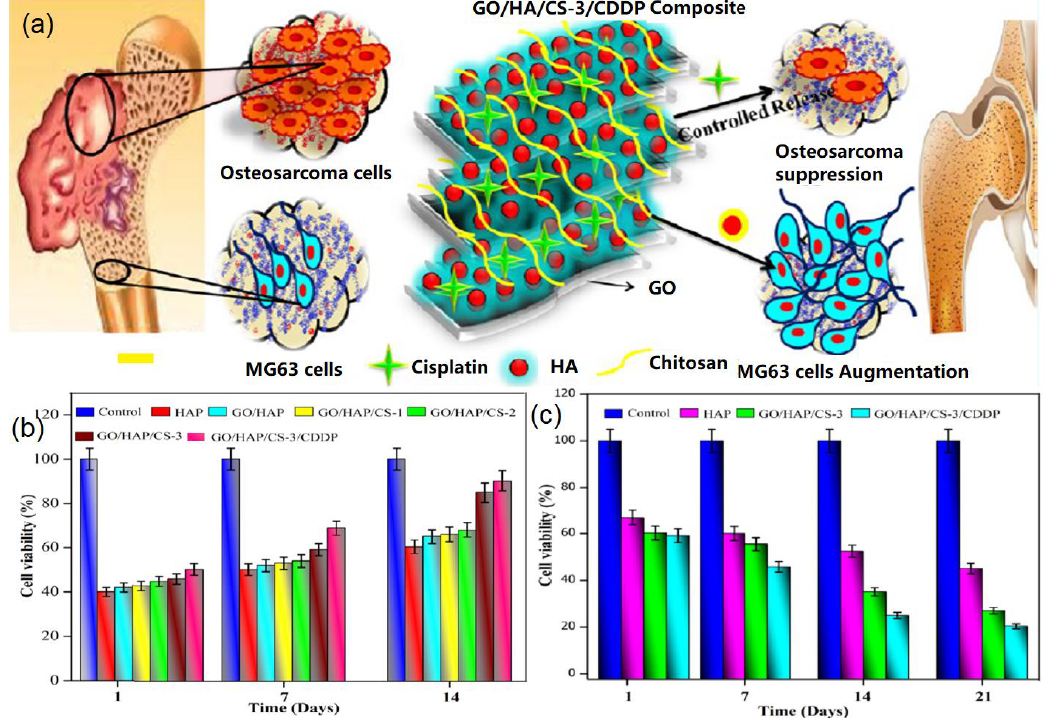
Figure 8. GO-HA nanohybrids for bone regeneration: ( a ) Bone regeneration mechanism, ( b ) MG63 cell viability on various samples, and ( c ) A549 cancer cell viability on different samples. Reproduced with the permission from [83]. Copyright 2018 American Chemical Society.